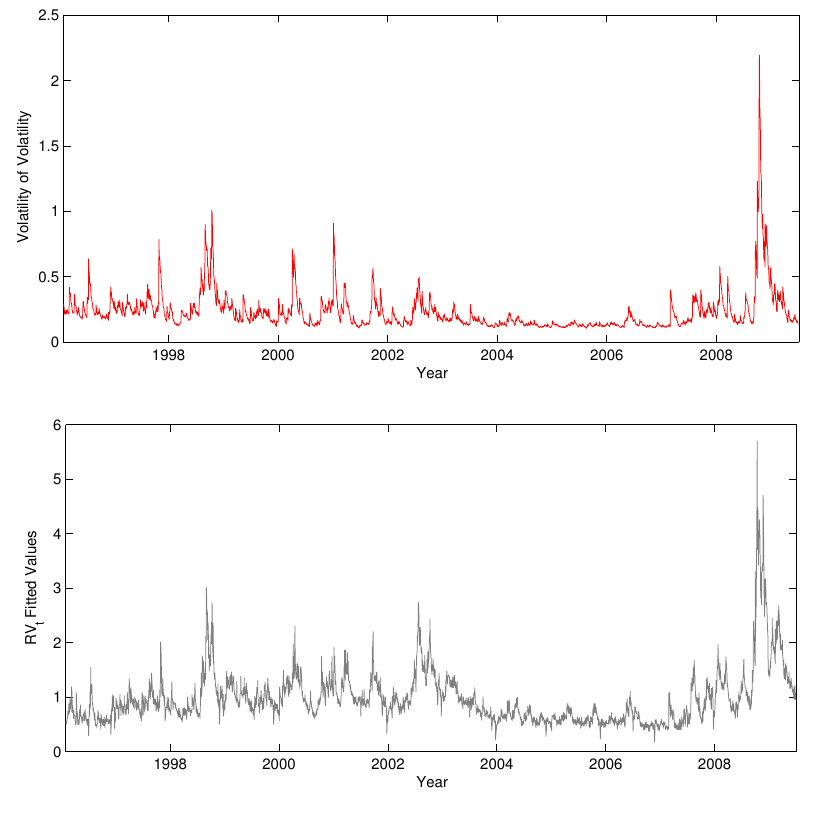
Figure 6. GARCHstandard deviation series ( top ) and realized volatility fitted values ( bottom ) for the HAR model with leverage